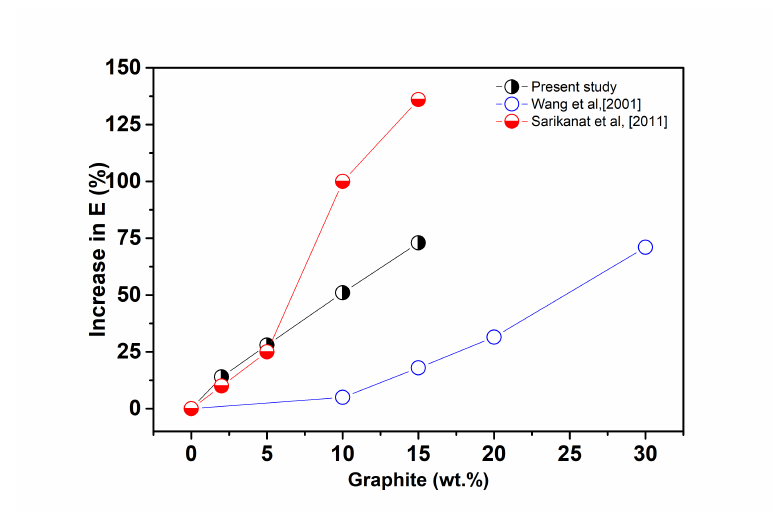
Figure 6. Modulus of elasticity enhancements of the PET/graphite composite: ( top ) modulus enhancements with respect to various filler concentrations in our study; and ( bottom ) our study and literature values, a comparison.